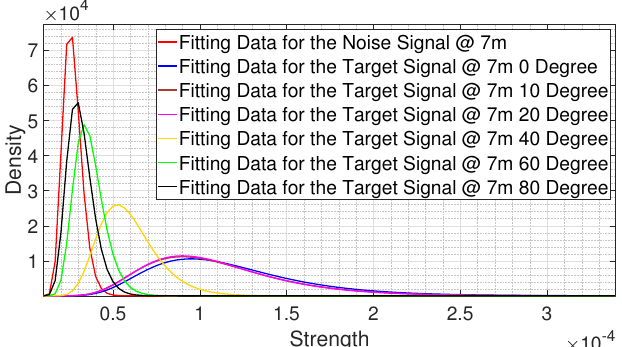
Figure 12. The fitting results for the signals reflected from a person at different angles of 7